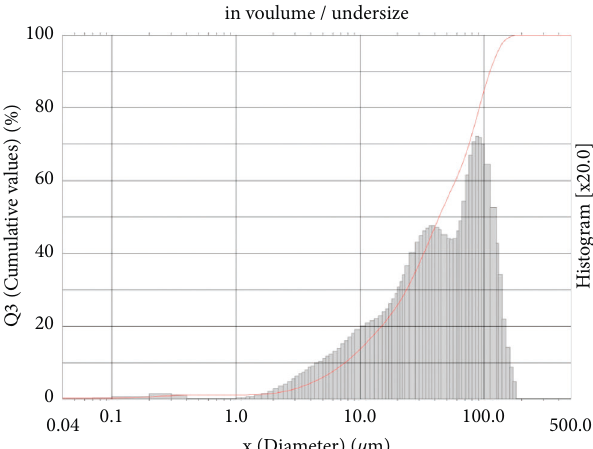
Figure 2: Particle size distribution from microcapsules of R . tuberosa (L.) extracts prepared in pH 4, 0.1% (w/v) chitosan concentration and 90min stirring time. The mean diameter was 53.41 μ m.